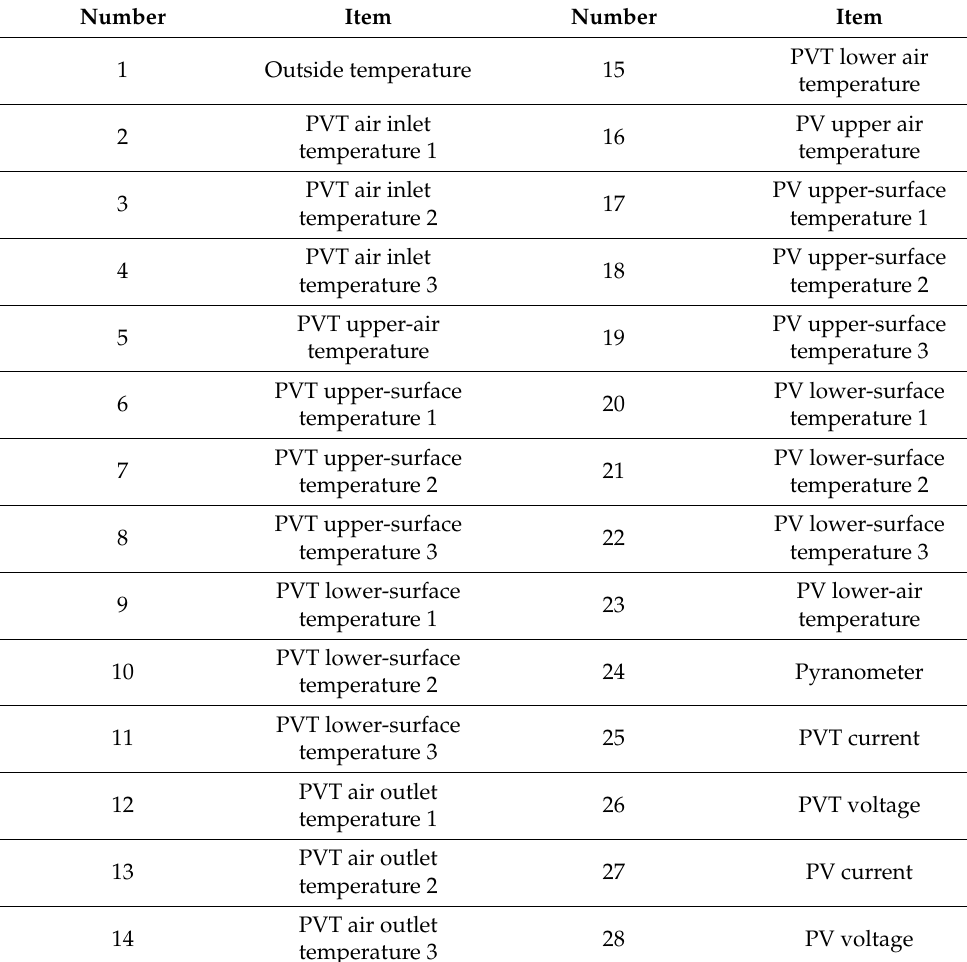
Table 2. Measurement